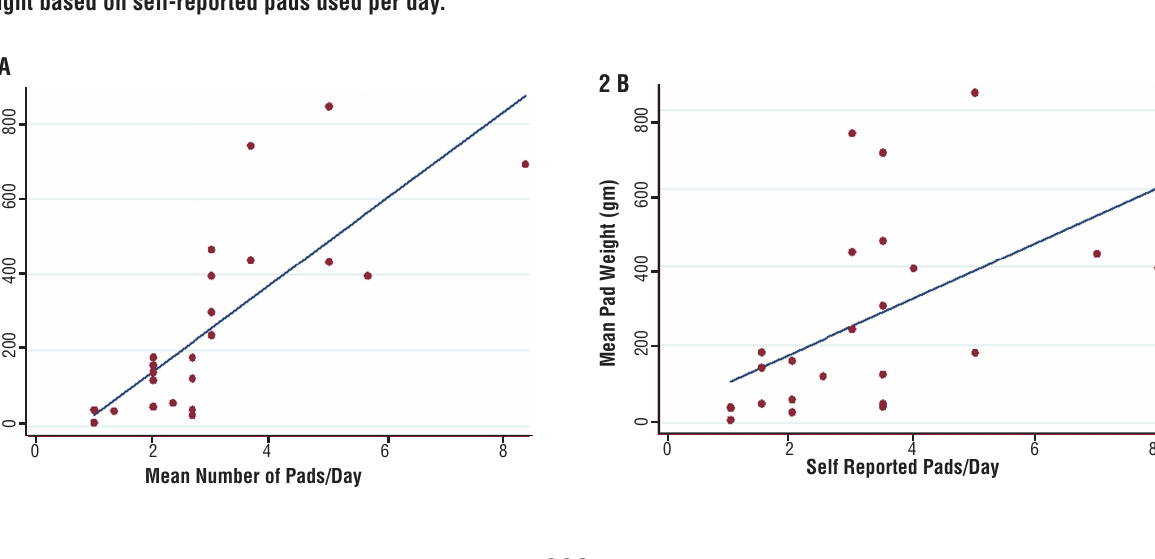
figure 2 - A. Change in mean 24-hour pad weight by mean number of pads used per day.B. Change in mean 24-hour pad weight based on self-reported pads used per